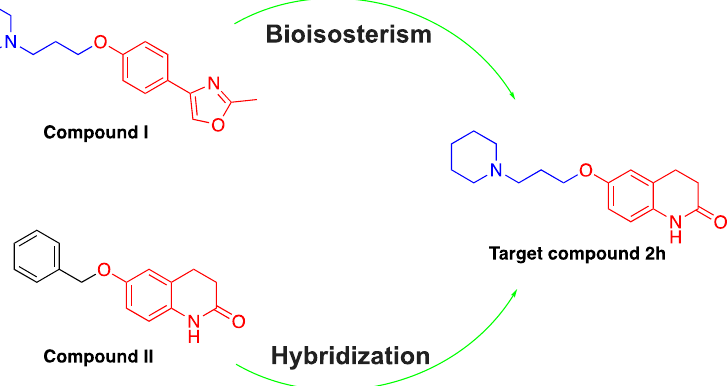
Figure 1. The structures of reported anticonvulsive compounds I , II , and target compound 2h